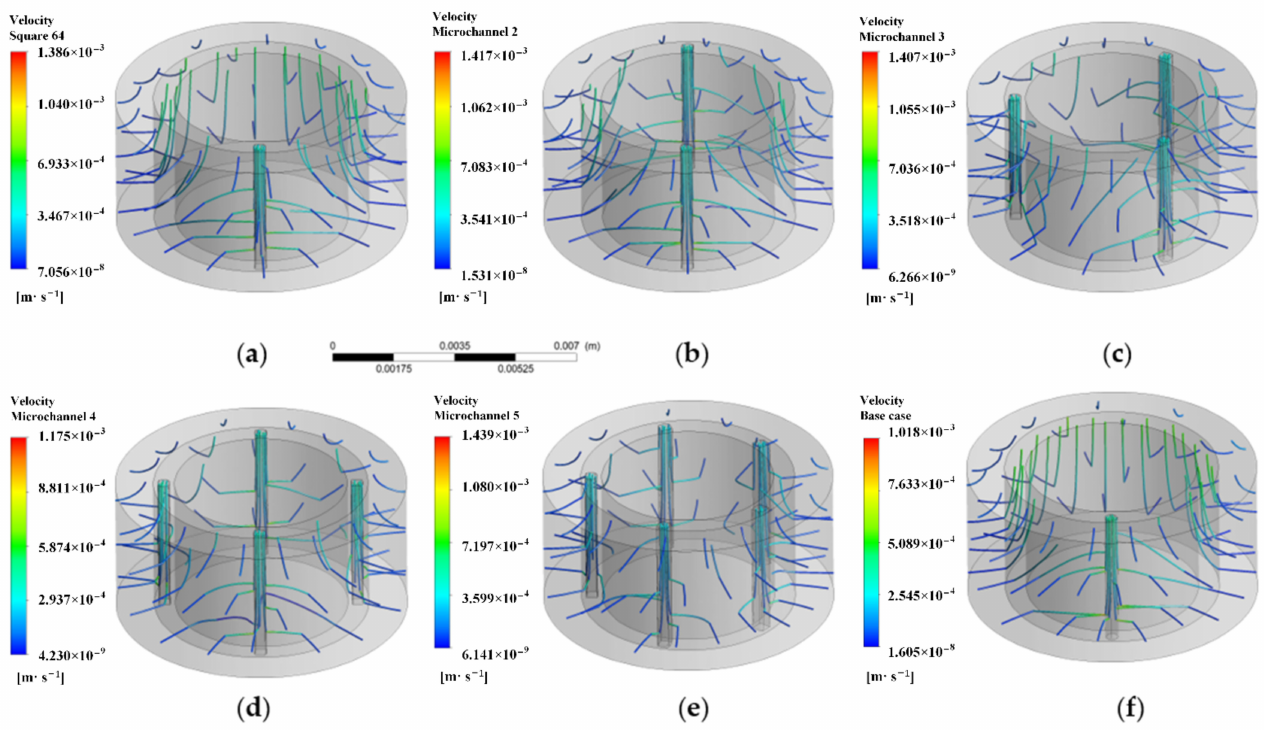
Figure 15. The velocity streamlines for cases with multiple microchannels and base case. ( a – f ): microchannel quantity = 1, 2, 3, 4, 5, 0 (base